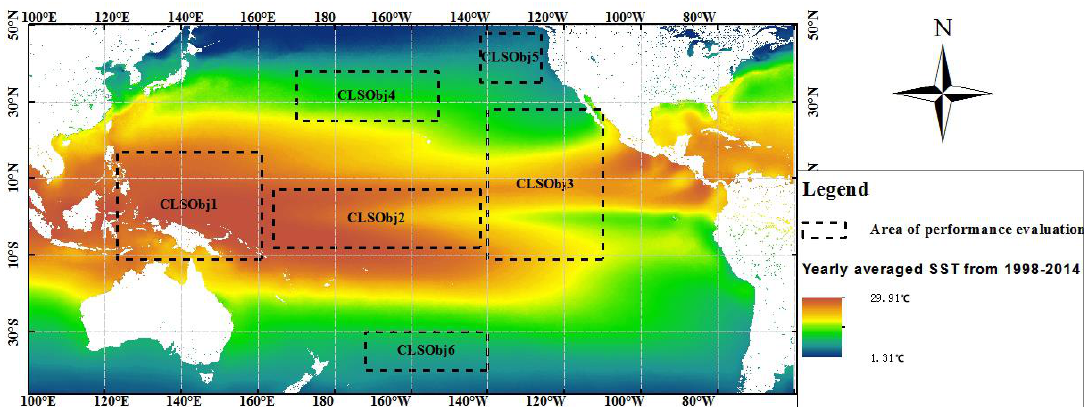
Figure 2. Research area. The background colors show the yearly average sea surface temperature (SST) from 1998 to 2014. Table 4. Sources and resolutions of the remote sensing images and multivariate ENSO index (MEI) used in this paper.